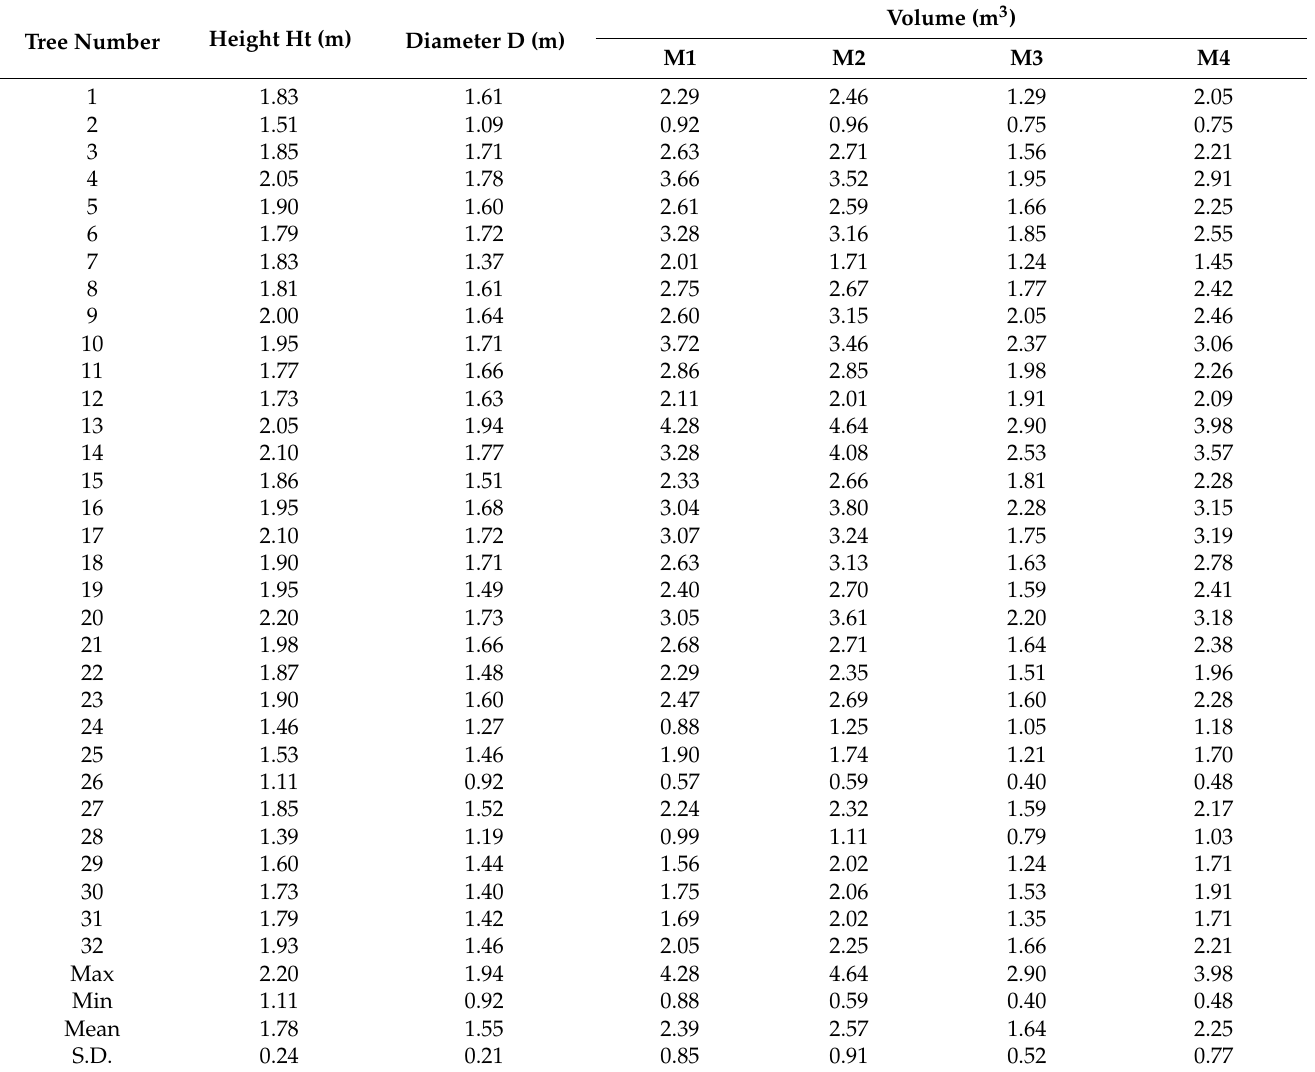
( a ) ( b ) ( c ) Figure 13. Schematic diagram of the results of three volume algorithms: ( a ) Convex hull by slices; ( b ) Voxel-based method; ( c ) 3D convex hull. Table 2. Canopy volumes obtained using the four calculation methods.